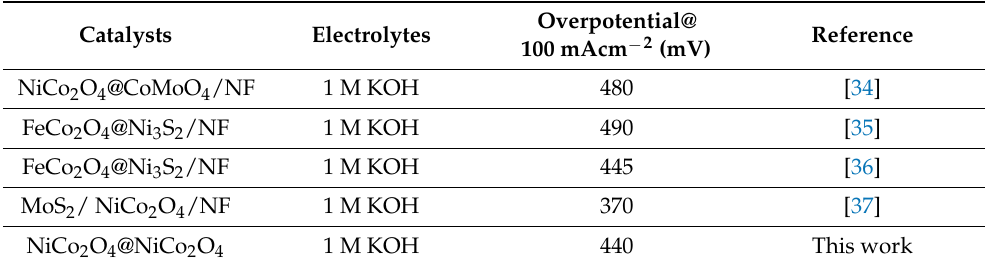
Figure 6. ( a ) LSV of core-shell NiCo 2 O 4 @NiCo 2 O 4 /NF composites, NiCo 2 O 4 nanosheets/NF, NiCo 2 O 4 naonocones/NF, pureNF, IrO 2 /NF; ( b ) core-shell NiCo 2 O 4 @NiCo 2 O 4 /NF composites prepared for different temperatures. Table 1. Comparisons of OER performance of the recently reported electrocatalyst [34–37].